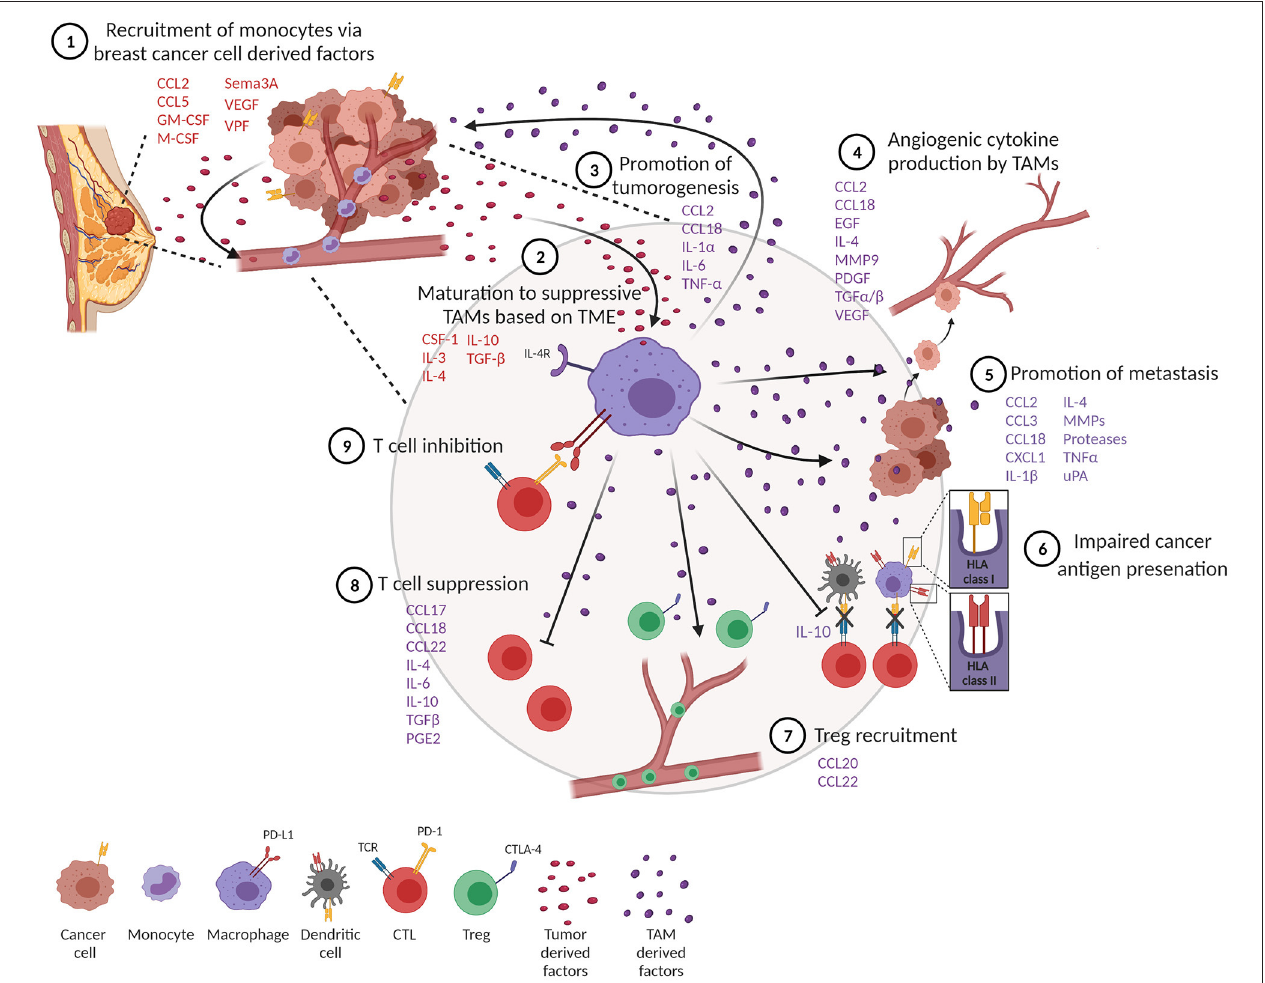
FIGURE 2 | Tumor-associated macrophages (TAMs) impede a productive anti-tumor immune response. (1) Monocytes are recruited to the tumor through tumor-derived factors. (2) One of the tumor monocytes mature to suppressive TAMs. (3) TAMs produce factors that promote tumor cell proliferation and survival. (4) TAMs promote angiogenesis and metastasis (5). (6) TAMs impair productive antigen presentation by dendritic cells and themselves downregulate MHC class I and II molecules. TAMs inhibit T cell function through recruitment of T regulatory cells (Tregs) (7) and suppression (8) and upregulation of co-inhibitory molecules